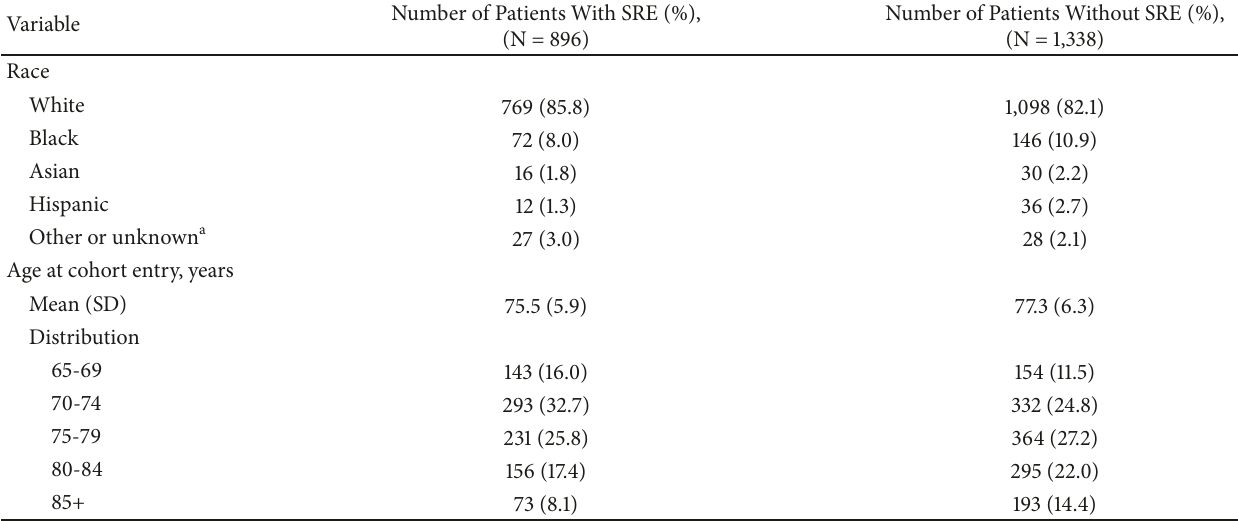
Table 2: Demographic characteristics of patients with and without SREs (N = 2,234) during follow-up.